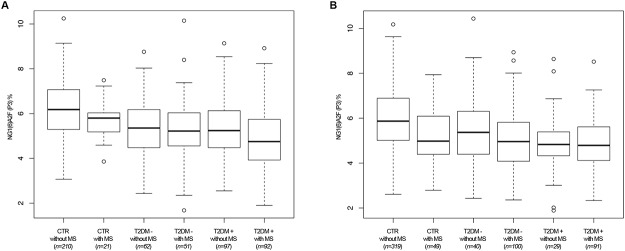
1A. The abundance of α(1,6)-arm monogalactosylated, core-α-1,6-fucosylated diantennary glycan NG1(6)A2F, assessed by peak 3 (P3) levels, in CTR and T2DM patients with and without MS.The boxplots represent a comparison of peak 3 levels in males in six classes of subjects: CTR without MS, CTR with MS, T2DM- without MS, T2DM- with MS, T2DM+ without MS, T2DM+ with MS. 1B. The abundance of α(1,6)-arm monogalactosylated, core-α-1,6-fucosylated diantennary glycan NG1(6)A2F, assessed by peak 3 (P3) levels, in CTR and T2DM patients with and without MS. The boxplots represent a comparison of peak 3 levels in females in six classes of subjects: CTR without MS, CTR with MS, T2DM- without MS, T2DM- with MS, T2DM+ without MS, T2DM+ with MS.